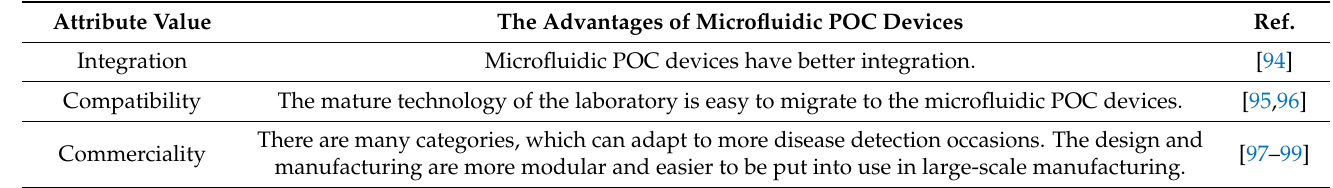
Table 2. The advantages of microfluidic POC devices over non-microfluidic POC devices. Attribute Value The Advantages of Microfluidic POC Devices Ref. Integration Microfluidic POC devices have better integration. Compatibility